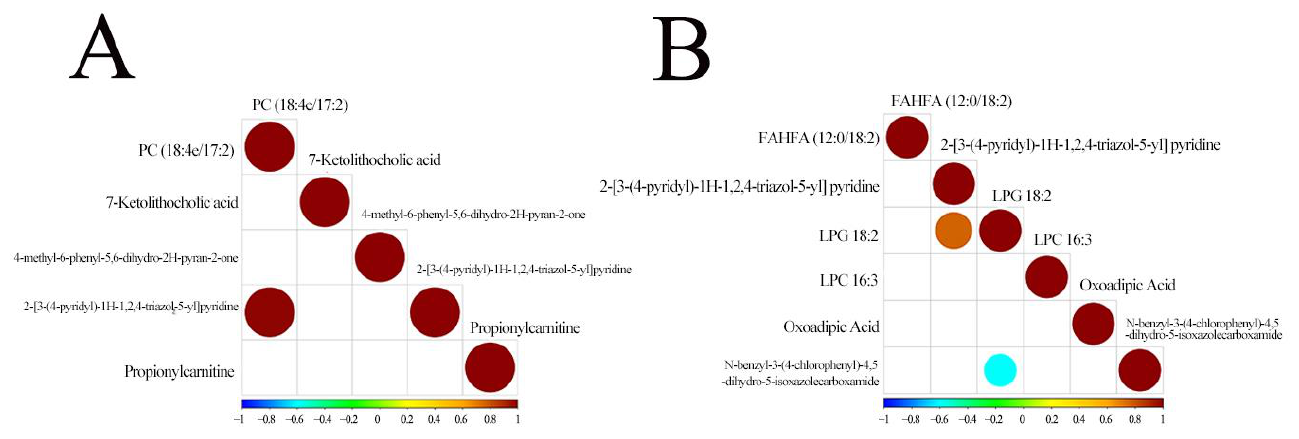
Figure 4. Correlation between the identified differentially metabolites in positive polarity mode ( A ) and negative polarity mode ( B ), where the deep color (red) and light color (blue) represent positive correlation and negative correlation, respectively.